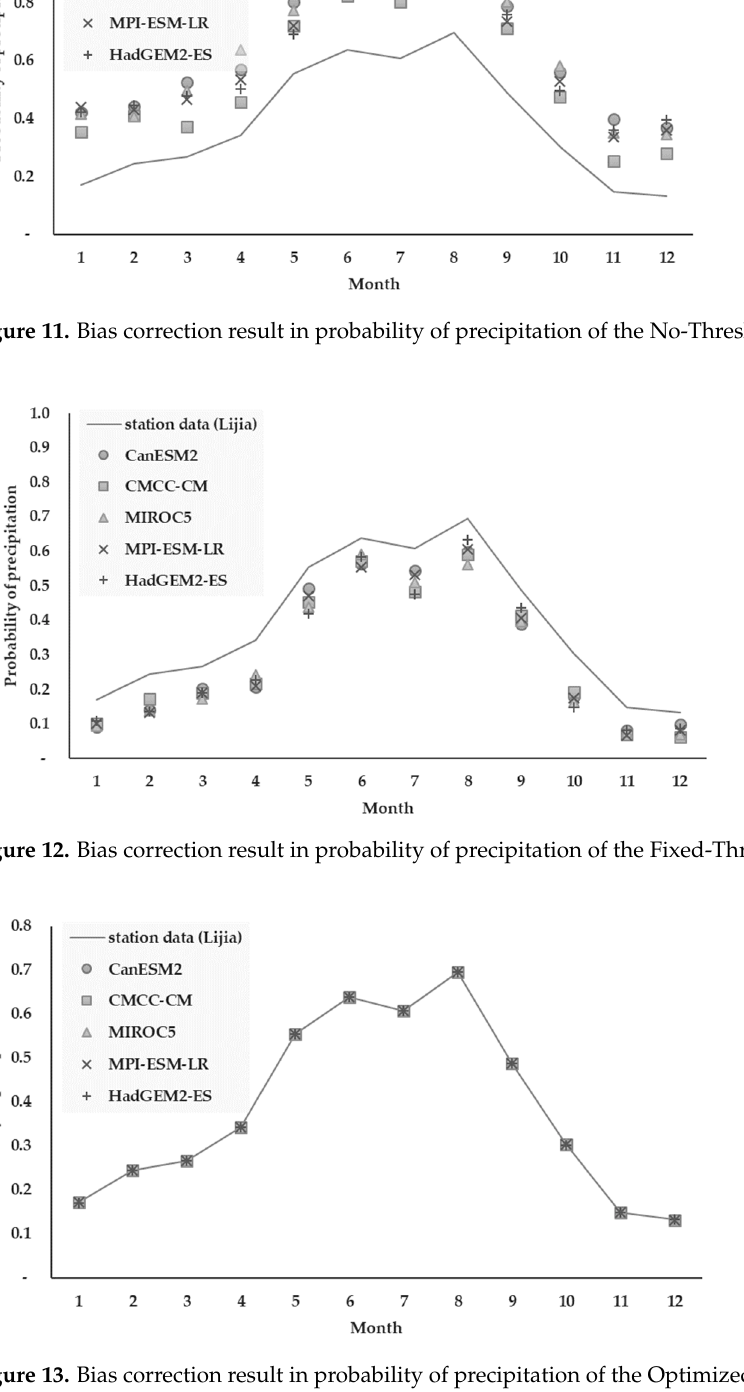
Figure 13. Bias correction result in probability of precipitation of the Optimized-Threshold method.